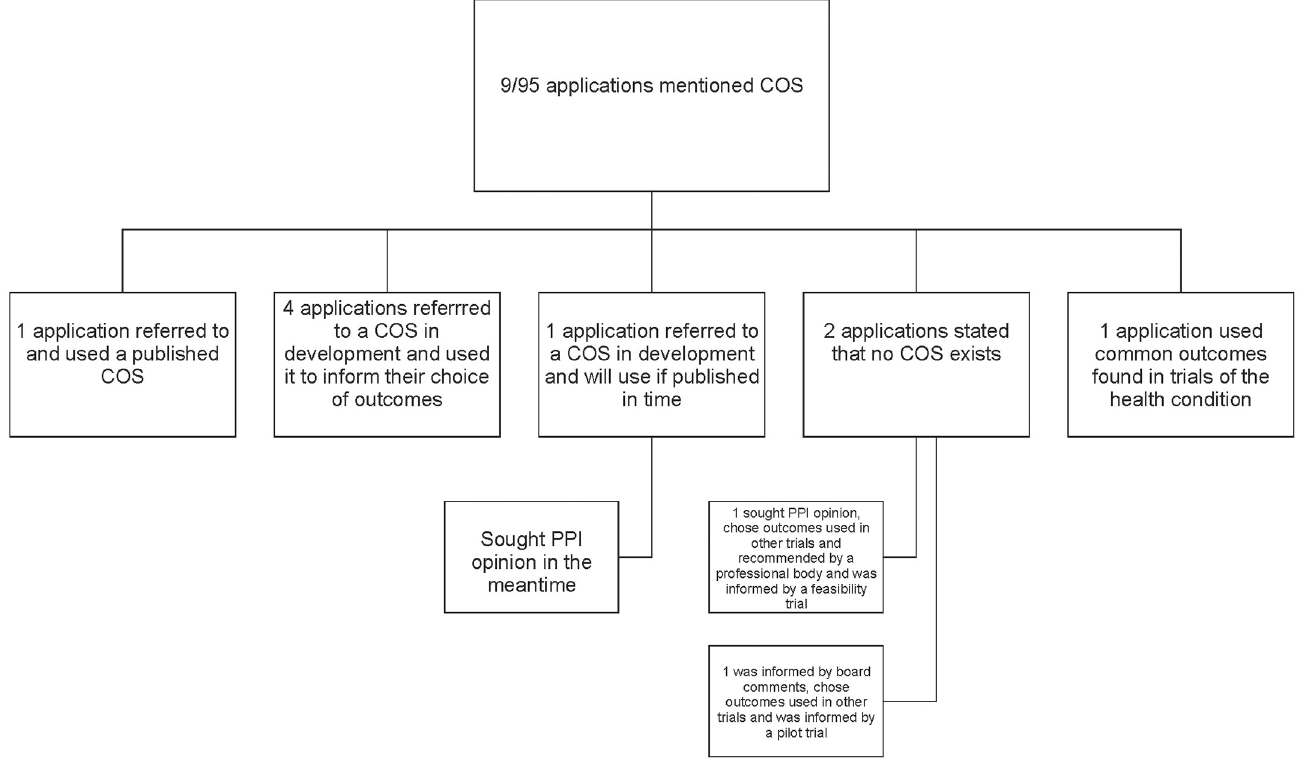
Fig 2. Applications that referred to a COS but did not make reference to the COMET database.